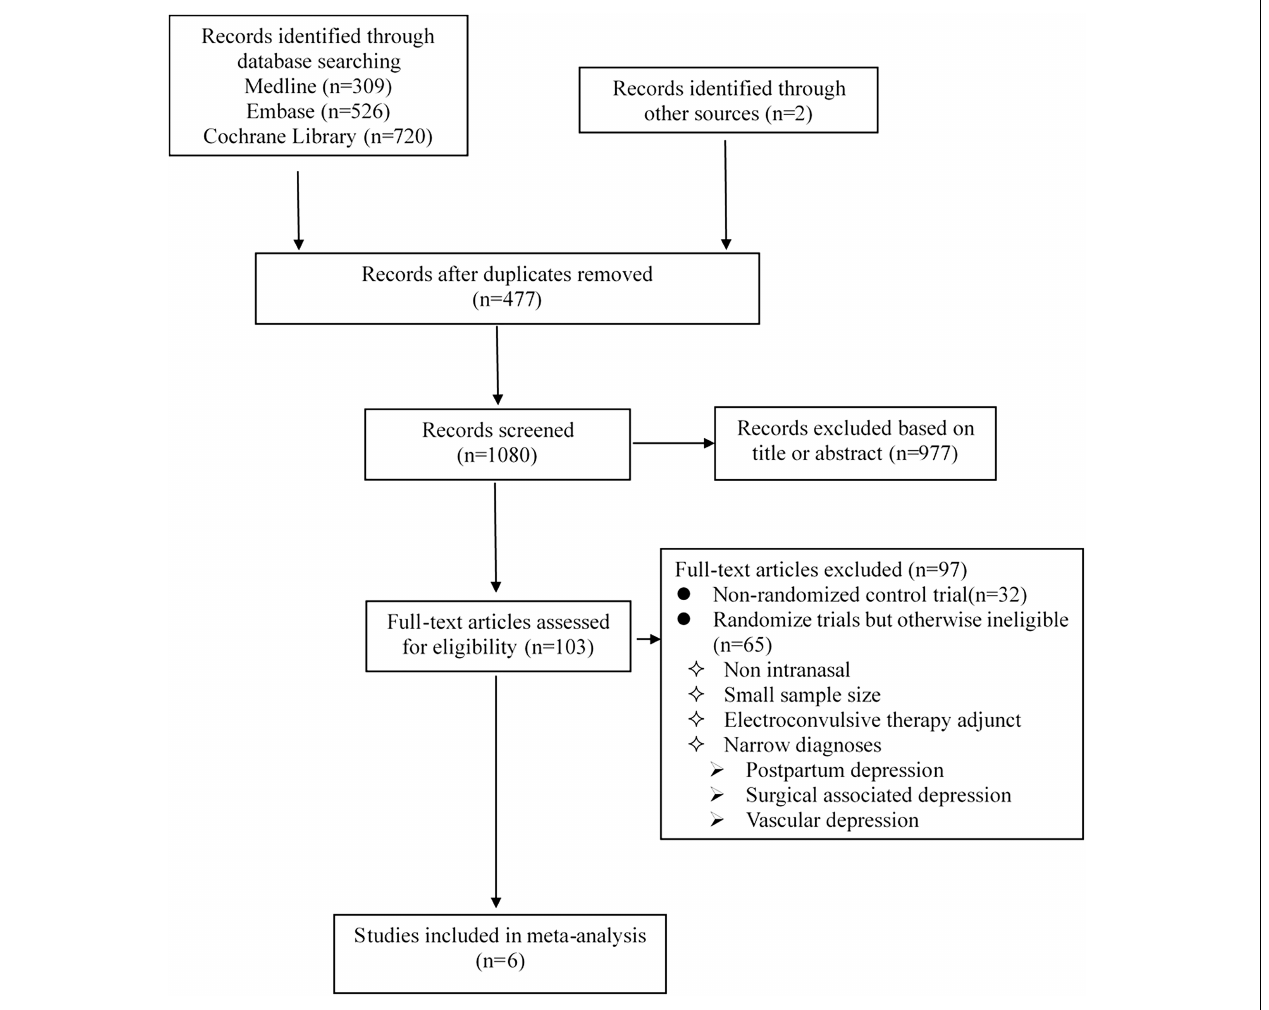
FIGURE 1 | Flow diagram for systematic